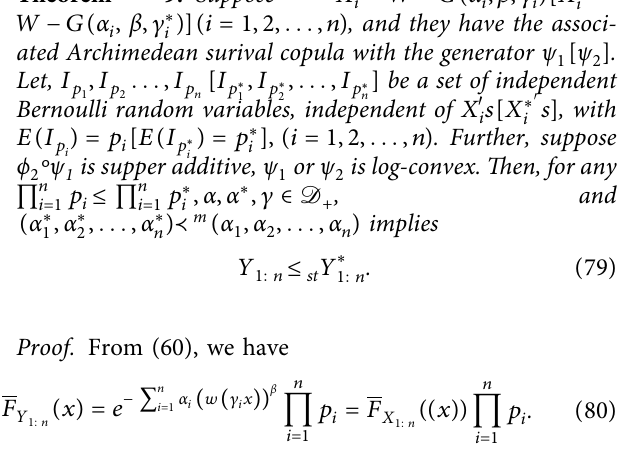
as is seen in Figure 6, F Y ∗ and u ∈ ( 0 , 1 ] , that is, Y